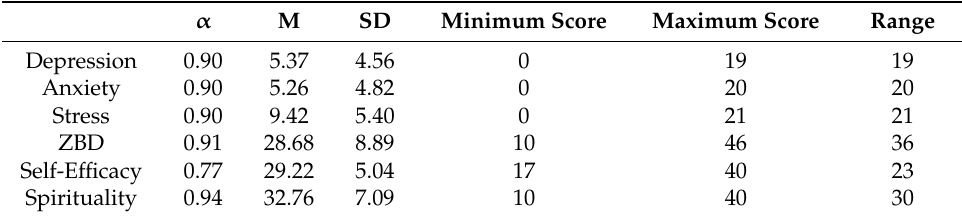
Table 3. Descriptive data of the measures.